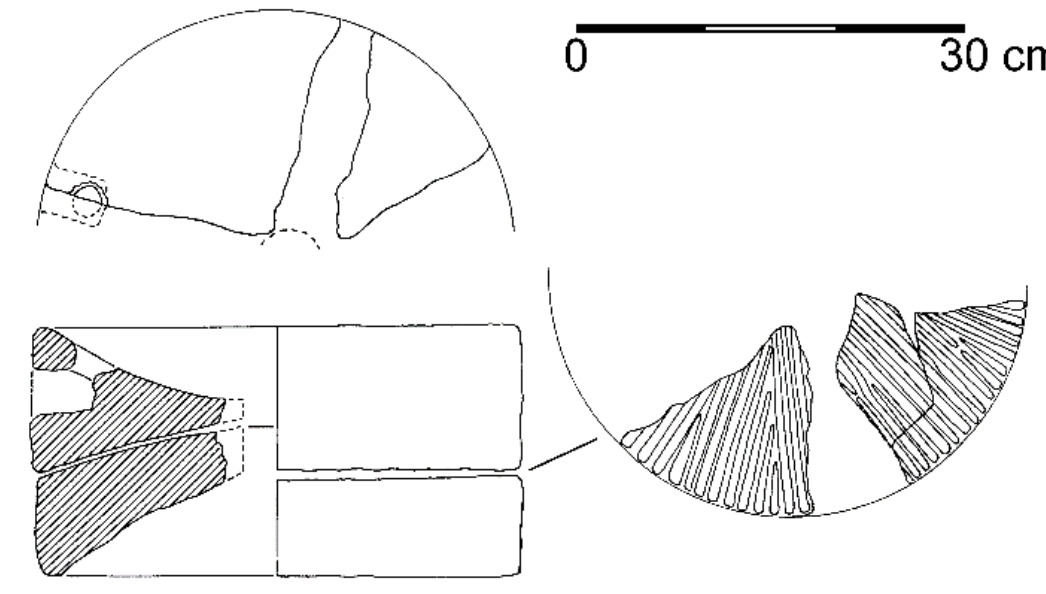
Figure 2. A pair of quernstones from Ettringen. “Basalt”-like lava. (Oesterwind 1997: fig.